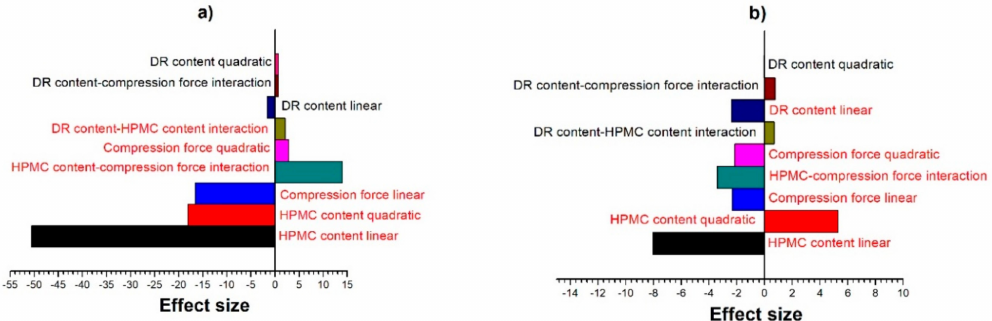
Figure 2. E ff ect of factors on the dissolution achieved at ( a ) 15 min and ( b ) 960 min. E ff ects were found significant at p = 0.05 are colored red. Interactions are